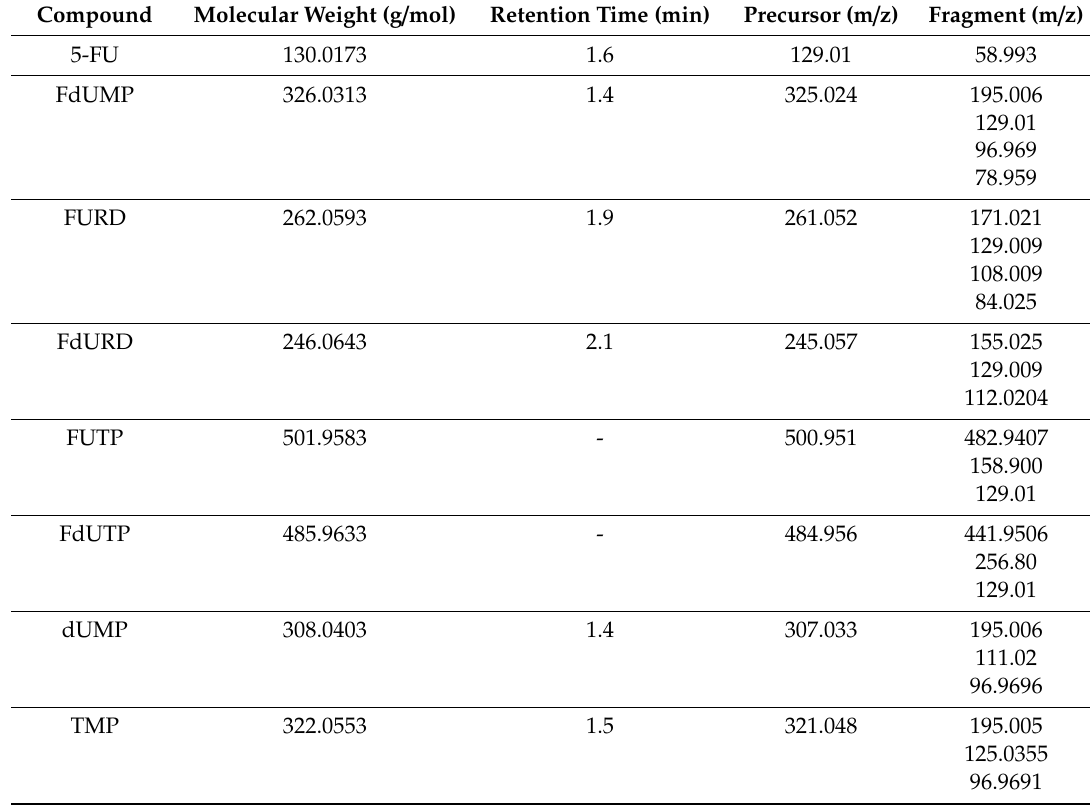
Table 3. The accurate mass of the precursor and fragment ions (fingerprint) used to identify 5-FU and the associated seven metabolites. The retention times that the targets were observed and detected in are shown in middle column in minutes, being polar in nature the compounds got eluted in lower retention time. ‘–‘ represents no